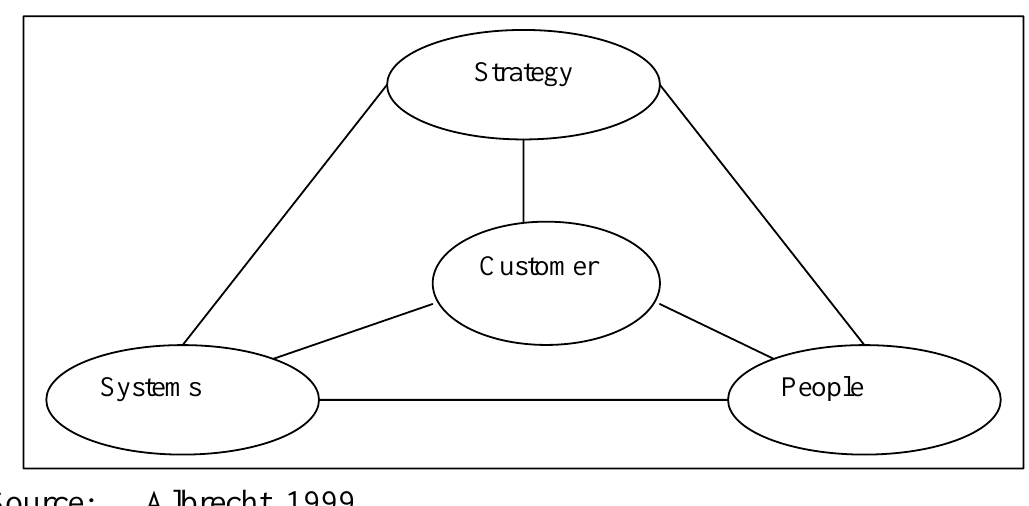
Figure 1.1 The service triangle